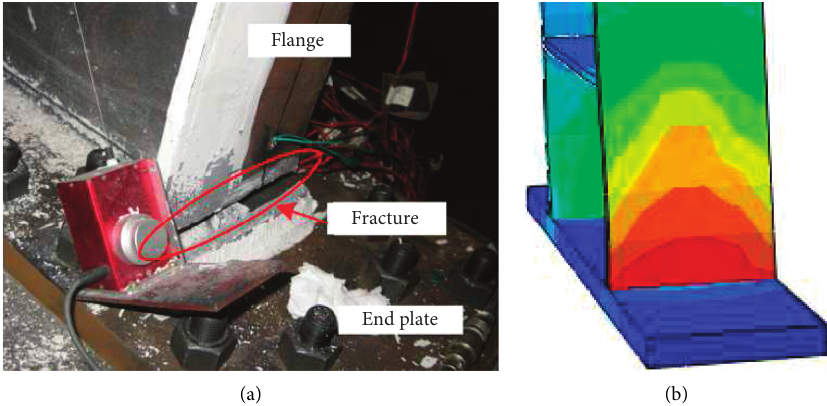
Figure 5: Analyzed failure of specimen: (a) test result [9]; (b) numerical